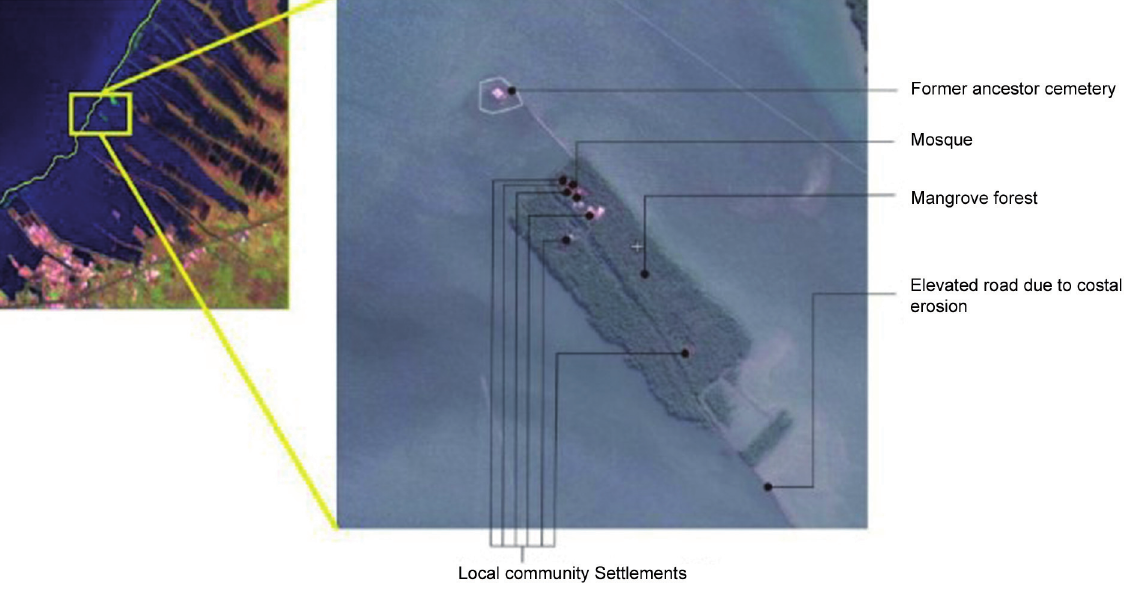
Fig. 3. High resolution image shown Tambaksari-Sayung area as the small area left due to coastal